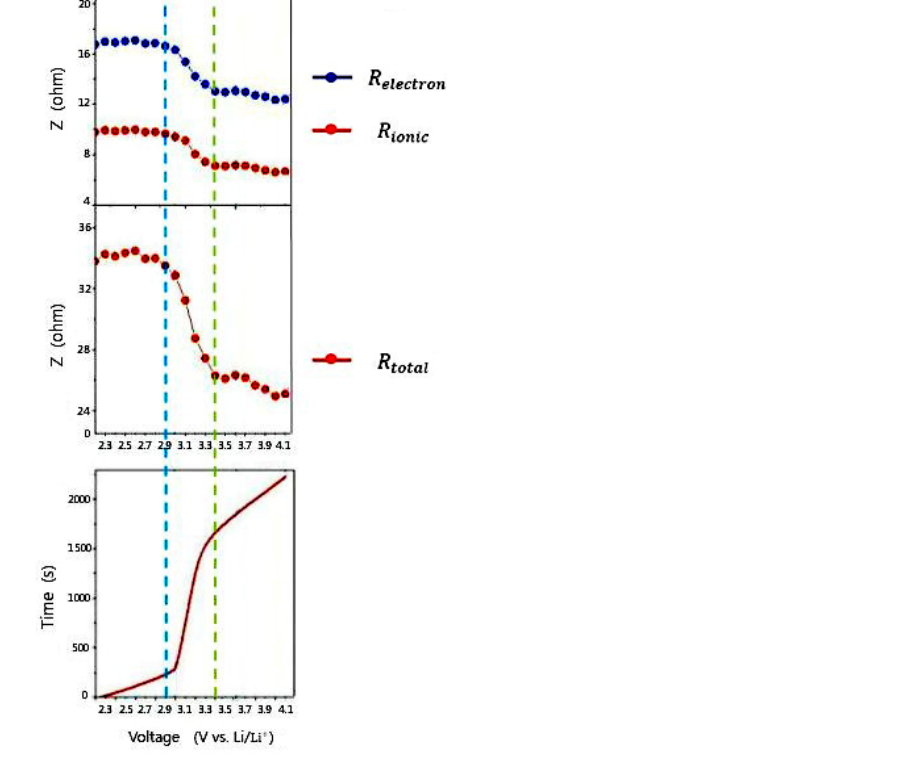
Figure 4. Classification results based on electrochemical characteristics of HyLICs.